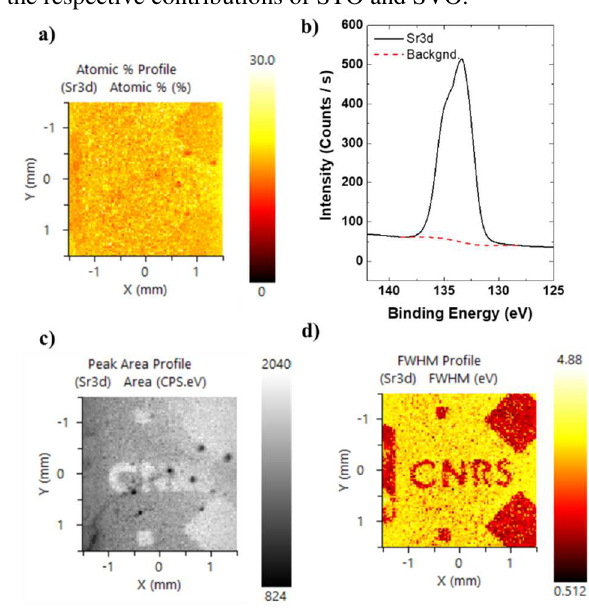
Fig. 3. Quantitative XPS map (3 mm x 3 mm) of the STO/SVO stack for Sr3d (a) and its corresponding integrated spectrum (b). Sr3d area (d) and FWHM (d) maps on the same region of